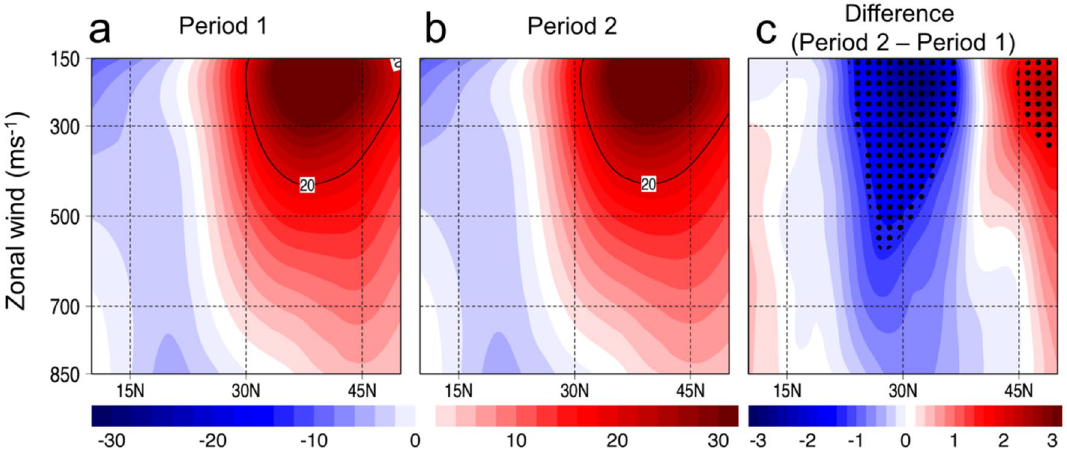
Figure 5. Changes in the East Asian subtropical jet stream. ( a ), ( b ) Composite vertical cross-section of zonal wind (850–150 hPa) averaged from 110° to 150°E during Period 1 (1981–2002) and Period 2 (2003–2020), respectively. ( c ) Composite difference between Period 2 and Period 1. The dots indicate significance at p < 0.05. The maps are plotted using GrADS v2.2.1 (http:// openg rads.